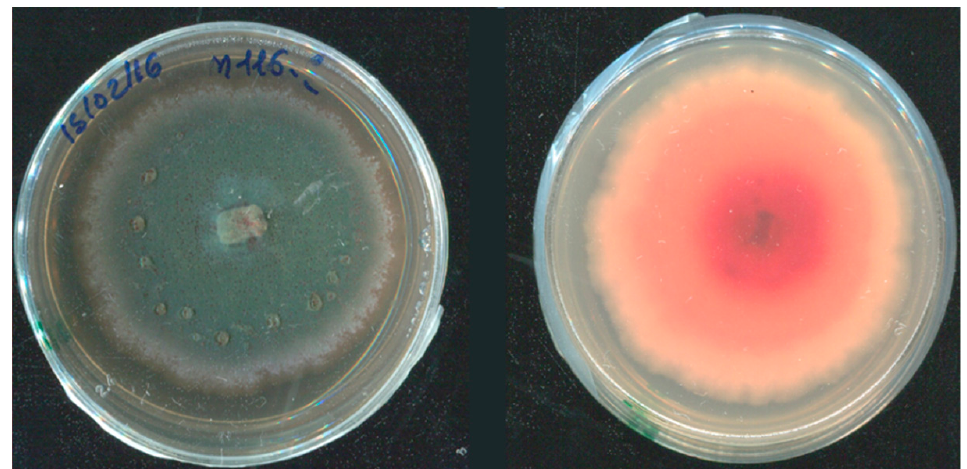
Figure 2. Penicillium s.l. decay. ( A ) Necrotic lesion covered with blue ‐ greenish sporification. ( B ) Cracking ( C ) wound and ( D ) infected stamens.